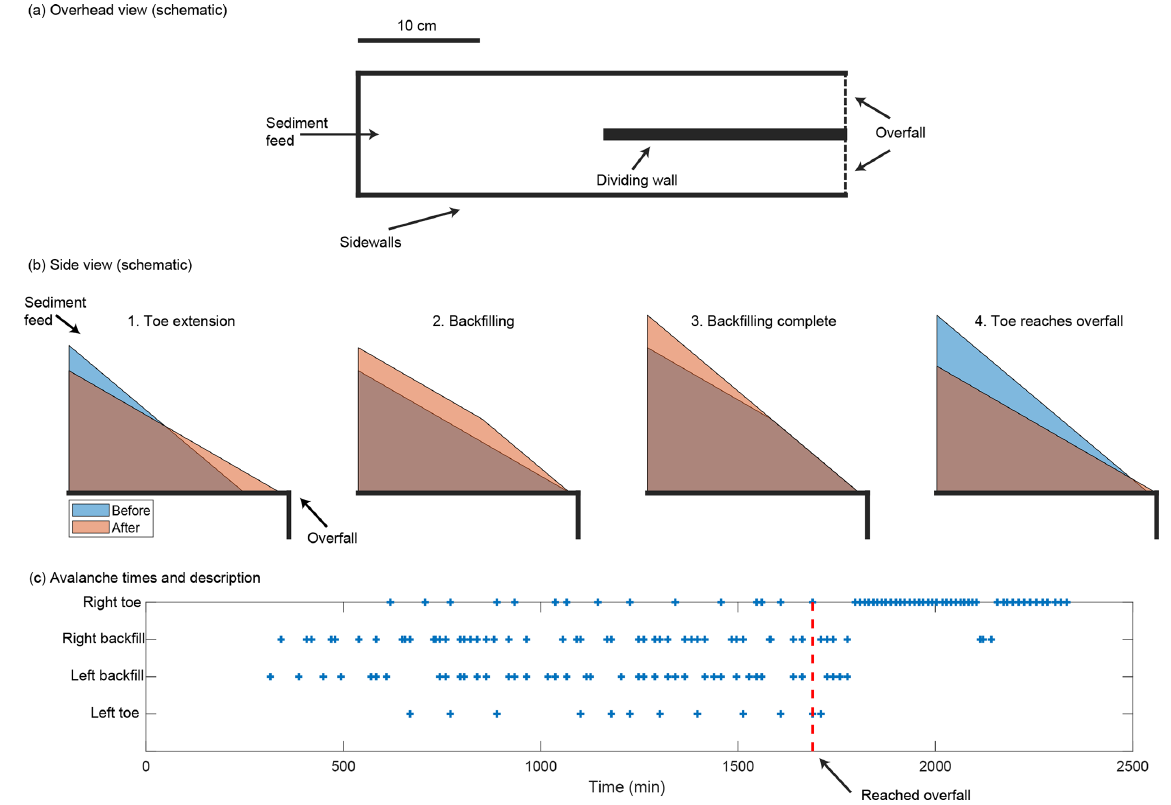
Figure 9. (a) Schematic of the experimental setup for the sandpile bifurcation experiments. (b) Schematic side view illustrating stages of sandpile growth. (c) Avalanche type and location vs. time. The dashed red line shows when the sandpile toe first reached the overfall (table